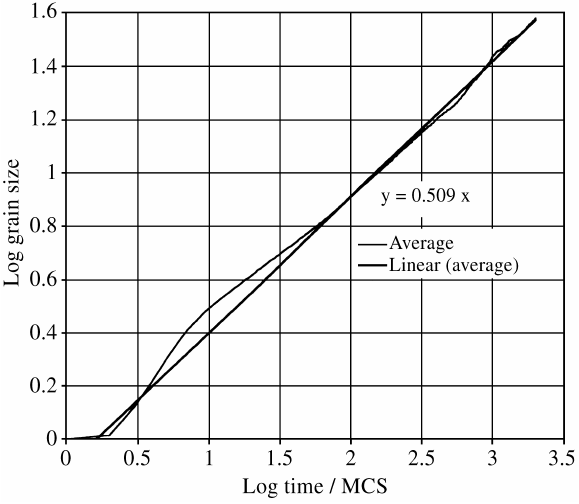
Figure 9. Grain size vs. time (5000